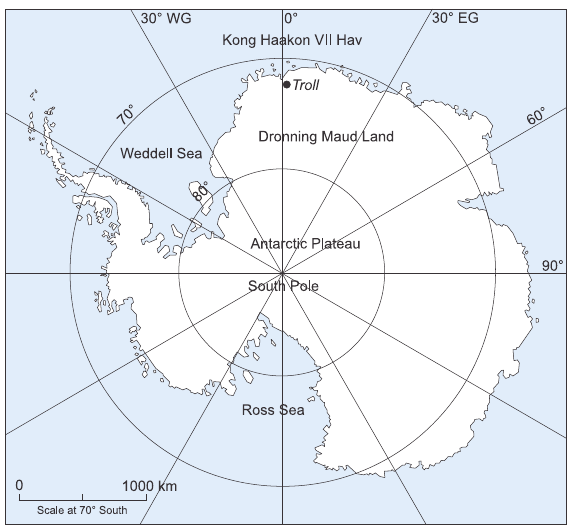
Fig. 1. Map of Antarctica indicating the location of TRS and other geographical areas referred to in the